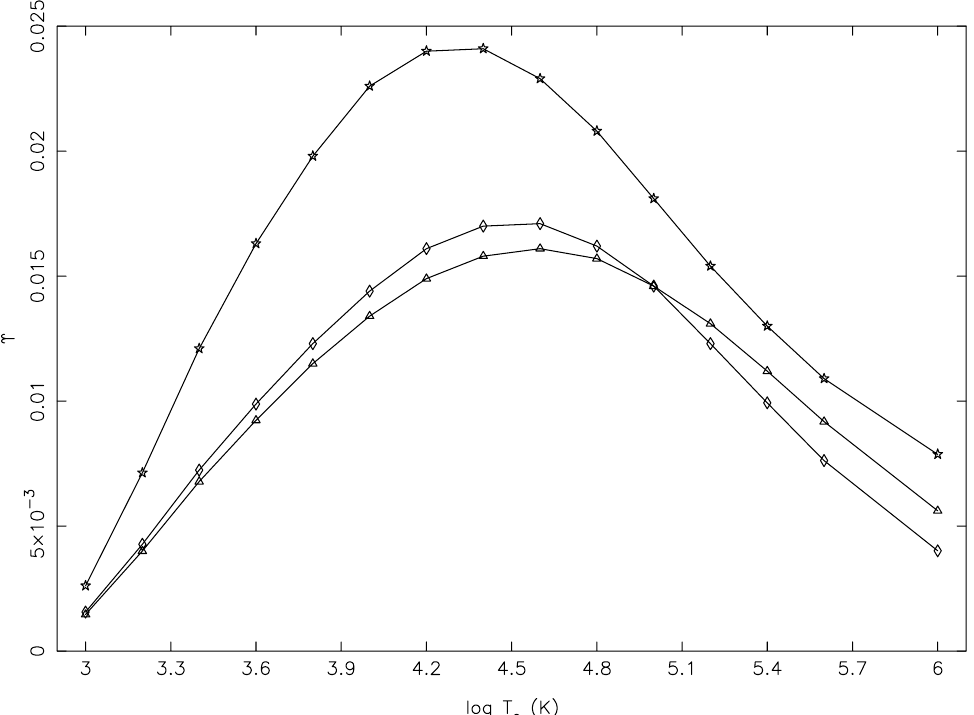
Figure 11. The BSR values of Υ by Tayal et al. [1] for the 1–198 ((triangles: 3p 2 3 P 0 –3s3p 2 ( 2 P)3d 3 D 1 ), 6–198 (diamonds: 3s3p 3 ( 4 S) 5 S o –3s3p 2 ( 2 P)3d 3 D 1 ), and 24–198 ((stars: 3s 2 3p4s 3 P o 2 transitions of S III.